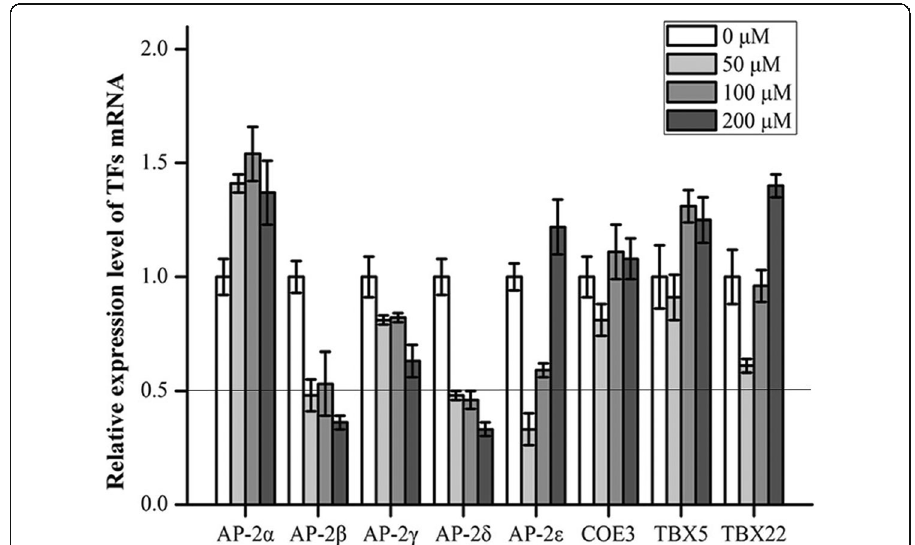
Fig. 2 Relative expression level of TFs mRNA in HEI-OC1 cells treated with 0 μ M, 50 μ M, 100 μ M, and 200 μ M t-BHP for 24 h. mRNA level was assayed by qRT-PCR and normalized against the control group